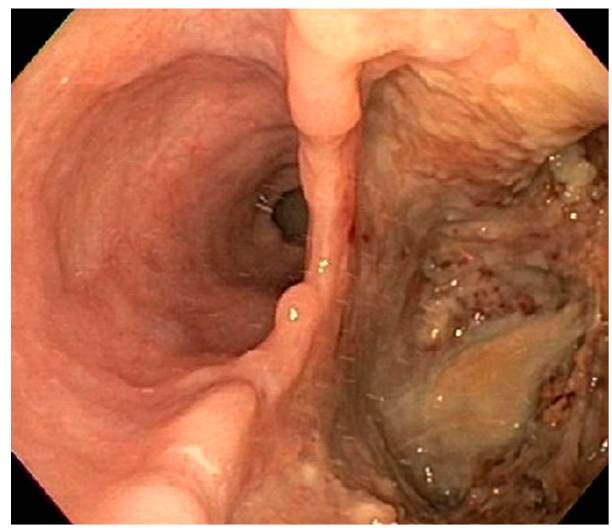
Figure 14. Large erosive mass noted on EGD about 22 cm from incisors.